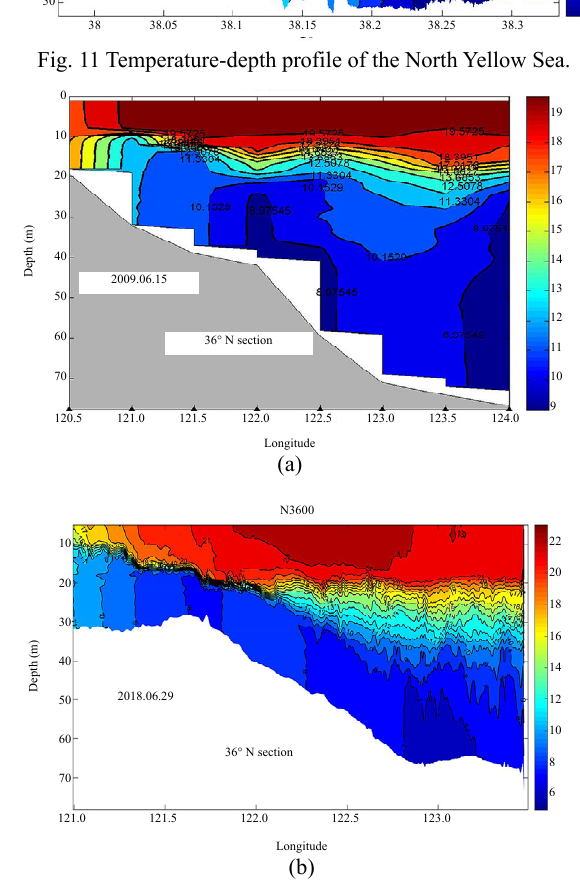
Fig. 12 Comparison of FBG sensor array and autonomous underwater vehicle (AUV) test data: (a) measured by autonomous underwater vehicle (AUV) and (b) measured by FBG sensor